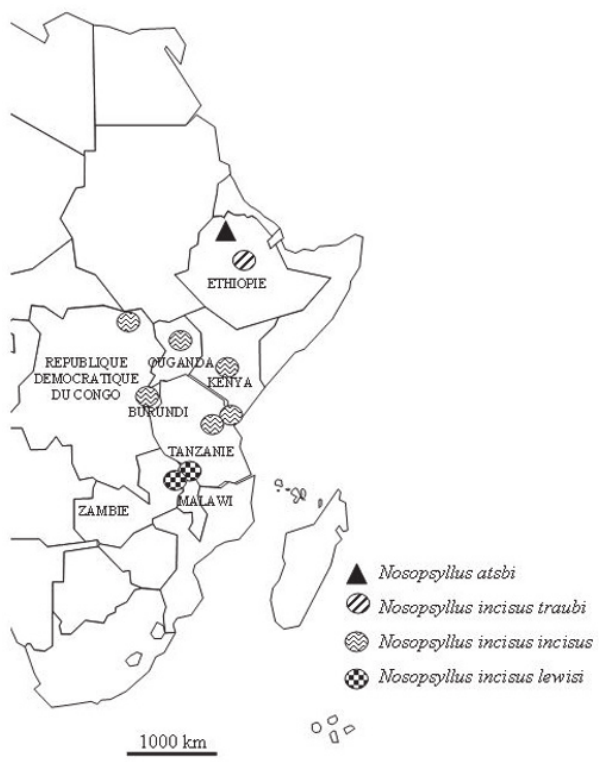
Figure 1. – Moitié orientale de l’Afrique montrant la dispersion du “complexe incisus ” : Nosopsyllus atsbi (nord de l’Éthiopie) ; N. incisus traubi (centre de l’Éthiopie) ; N. incisus incisus (J. & R.) (République Démocratique du Congo, Kenya, Ouganda, Burundi, Tanzanie) ; N. incisus lewisi (Zambie et Malawi, ces deux localisa- tions étant, semble-t-il, très proches, voire